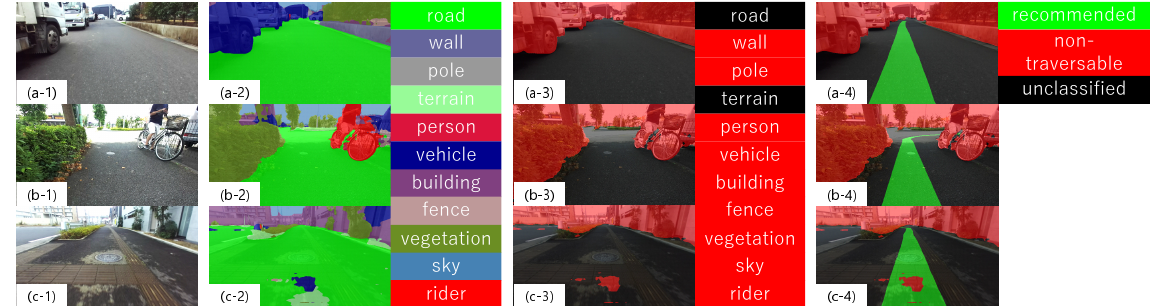
Figure 5. Example of non-traversable area labeling: Column 1, original image; Column 2, labeled image in 11 classes and colors to indicate each class; Column 3, labeled image of a class of non-traversable objects (road, wall, pole, person, vehicle, building, fence, vegetation, sky, and rider); and Column 4, labeled image of recommended area and non-traversable area. ( a-1 )–( c-4 ) are the image numbers referred to in the text.